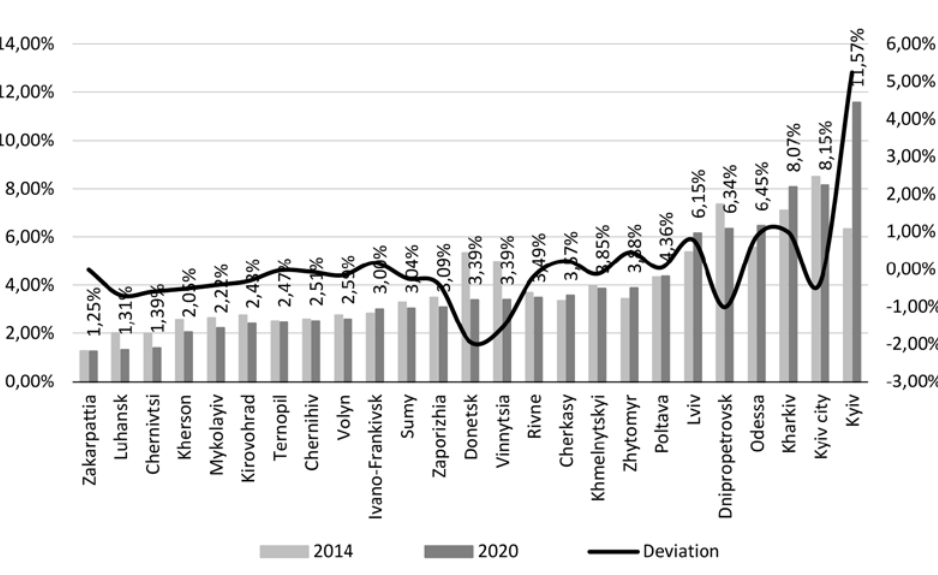
Figure 2. Participation of regions in internal migration in Ukraine by the indicator of arrivals intensity in 2014 and